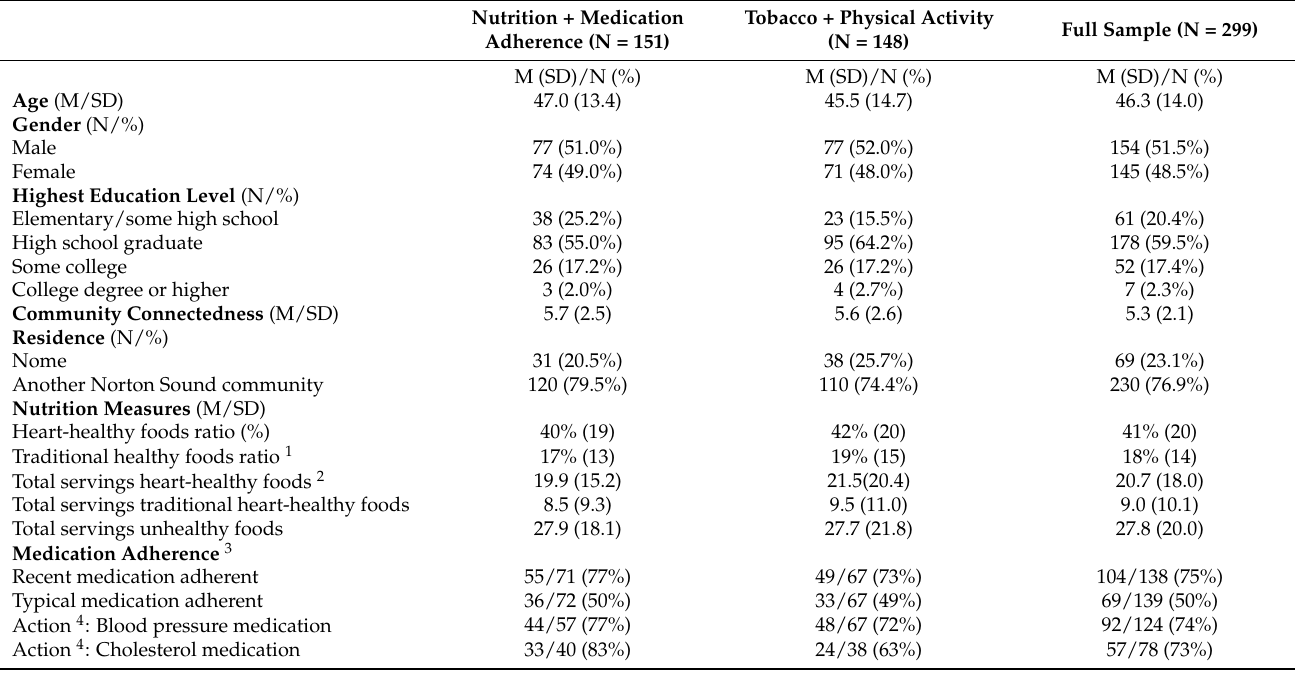
Table 2. HEALTHH Study Participant Baseline Characteristics (N =